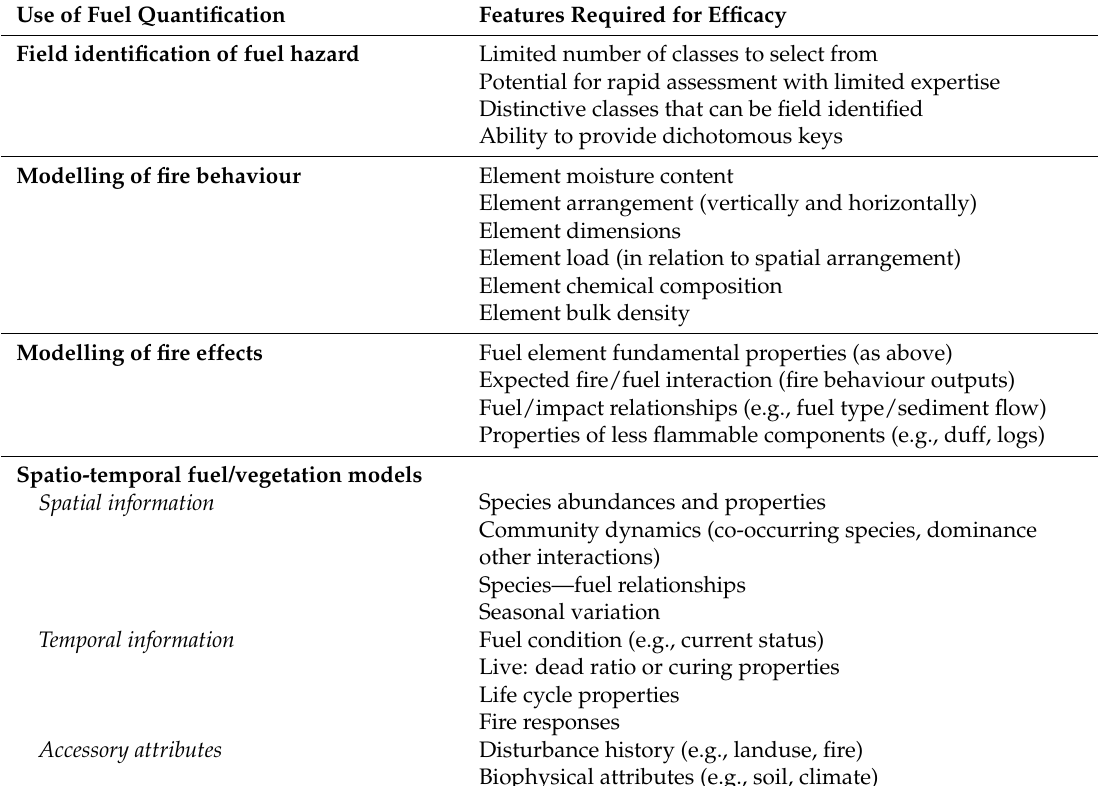
Table 3. Uses of fuel quantifications and key features required to fulfil desired